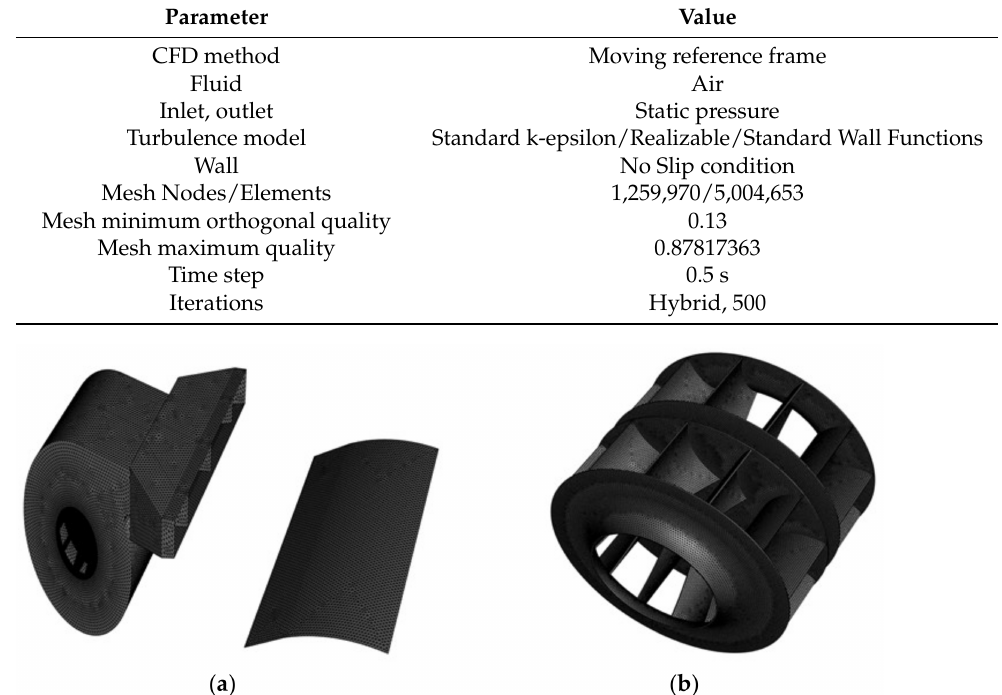
Table 5. Numerical analysis method for boundary conditions.